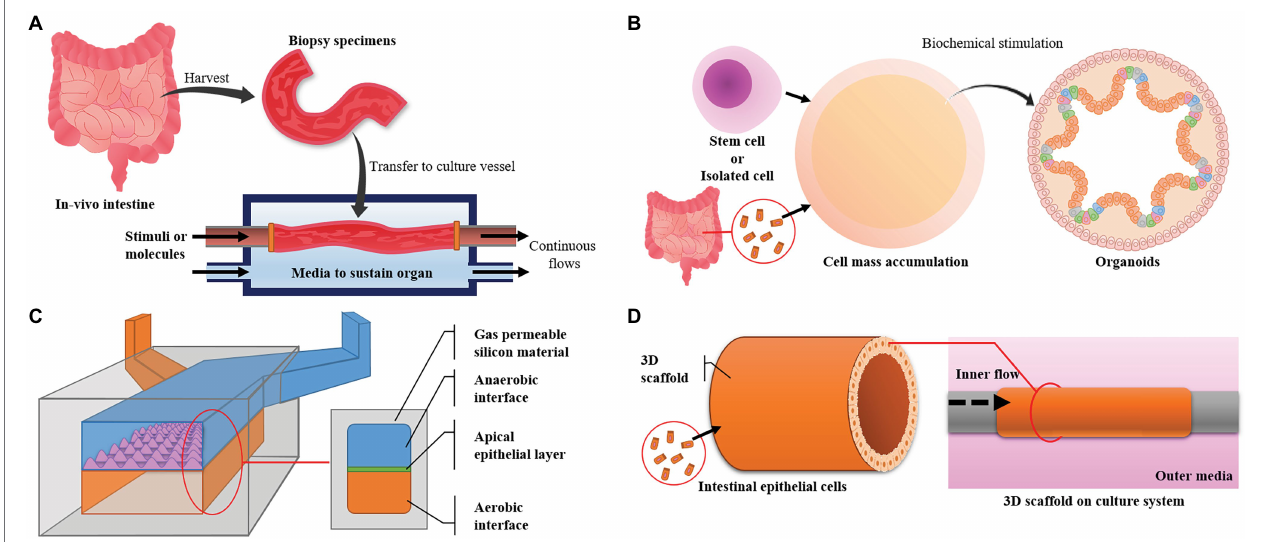
FIGURE 3 | Major intestinal models and their designs. (A) The ex vivo model uses intestine harvested from experimental animals and maintains its live state. It has high similarity, but the live state is hard to maintain. (B) Organoids are derived from pluripotent stem cells or cells harvested from in vivo tissue. The model has high similarity in function and cell composition but can only be maintained for a limited time. (C) Microfluidic devices can control the environment, are easy to observe and make it easy to focus on targets but have low productivity and a small area for experiments. (D) Three-dimensional (3D) cultures can provide large areas for experiments and high productivity but advanced techniques are required to simulate in vivo conditions and maintain a high level of